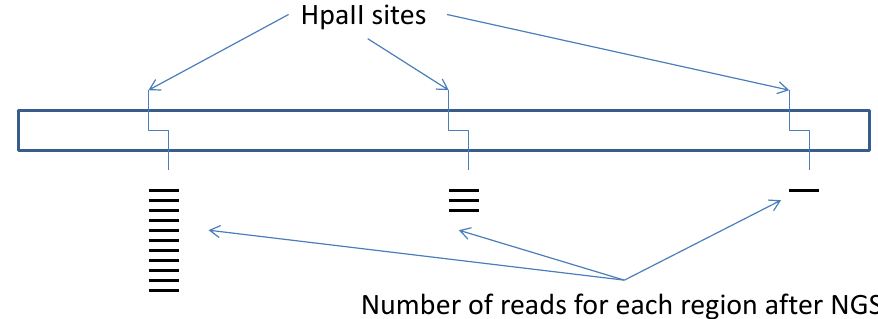
Figure 3. Scheme of the methyl-sensitive cut counting technique for elucidation of DNA methylation status for a particular gene of interest.